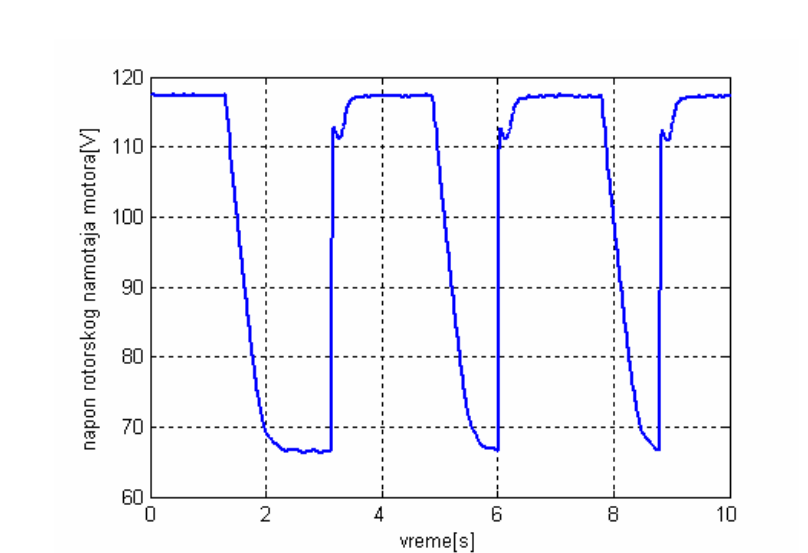
Figure 7 – Applied armature